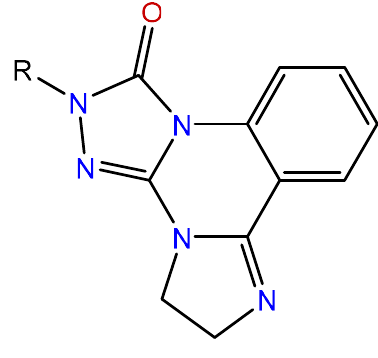
Figure 7. The common skeleton.